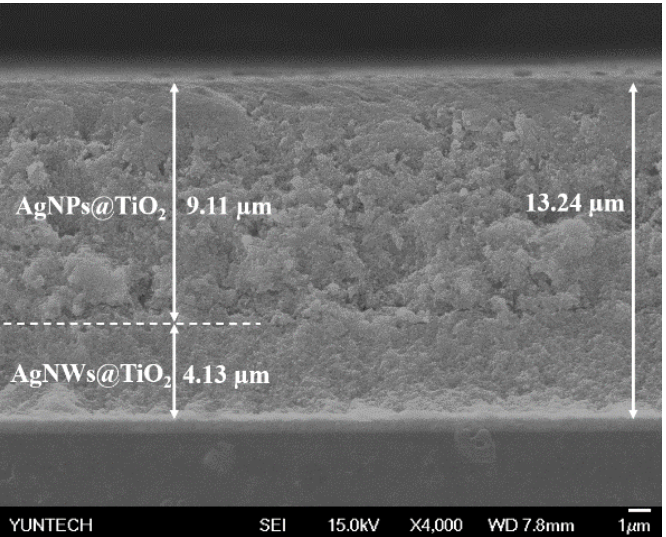
Figure 2. Field emission scanning electron microscope (FE-SEM) image of AgNWs@TiO 2 /AgNPs@TiO 2 photoanode cross-section view.